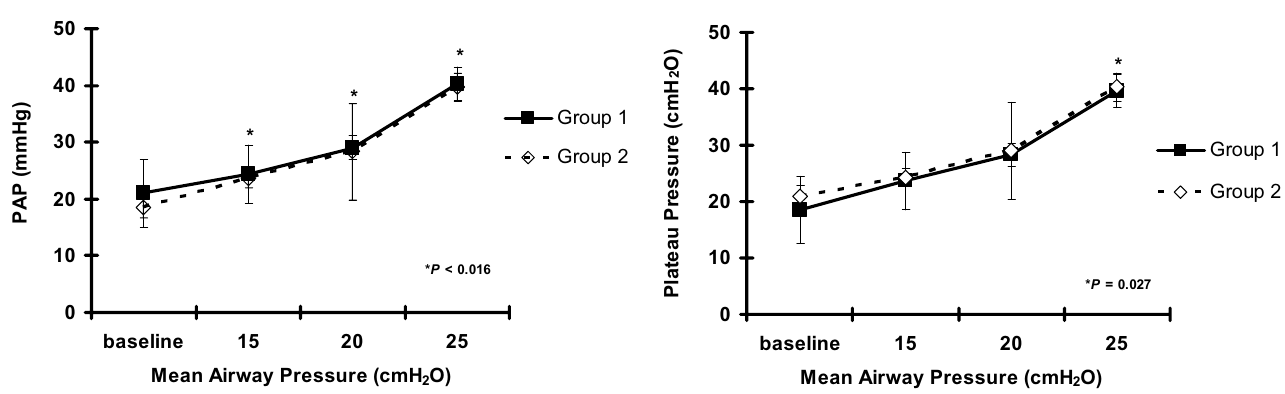
O caused a significant 2